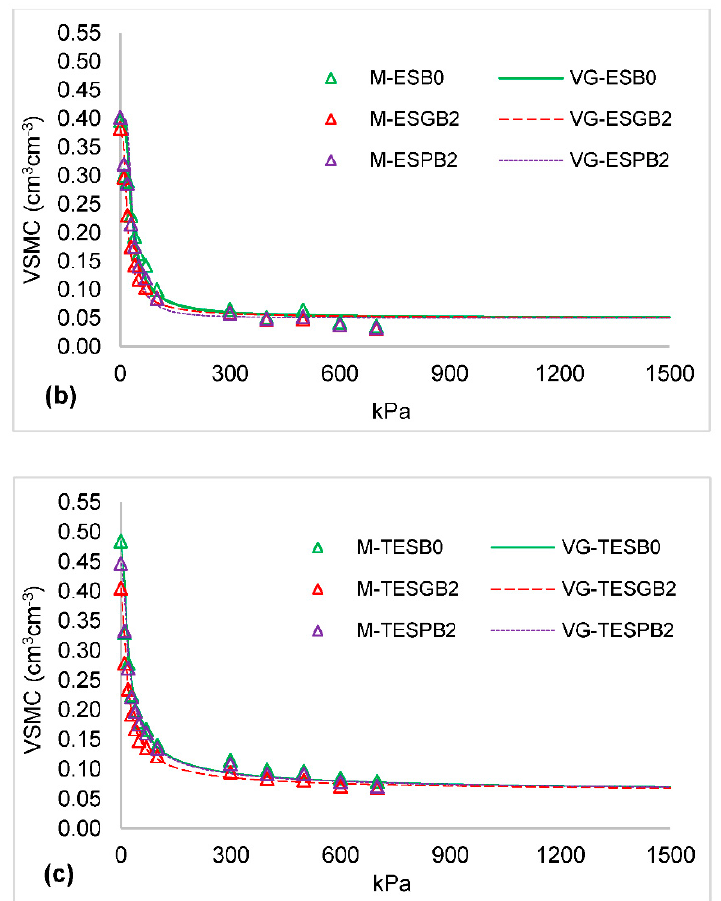
Figure 4. Soil water retention curve (SWRC) of measured (M) values vs. predicted values using van Genucthen (VG) equation up to permanent wilting point (PWP) at 1500 kPa for: ( a ) topsoil, ( b ) E-horizon soil and ( c ) mixed soil. Abbreviations: VSMC—volumetric soil moisture content; M-TSB0—measured topsoil with 0% biochar; VG-TSB0—predicted topsoil with 0% biochar; M-TSGB2—measured topsoil with 2% granular biochar; VG-TSGB2—predicted topsoil with 2% granular